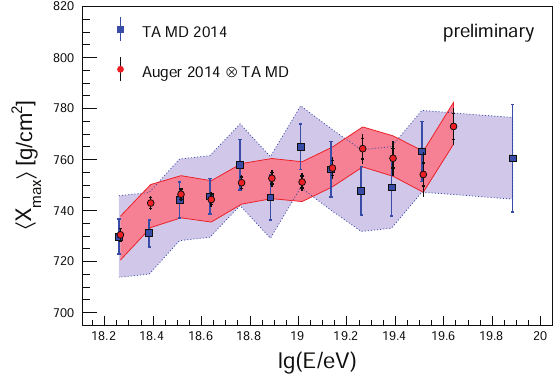
Figure 9. Comparison of the Auger [8] and TA Middle (cid:105) . The plot is taken from Drum [17] measurements of (cid:104) X max